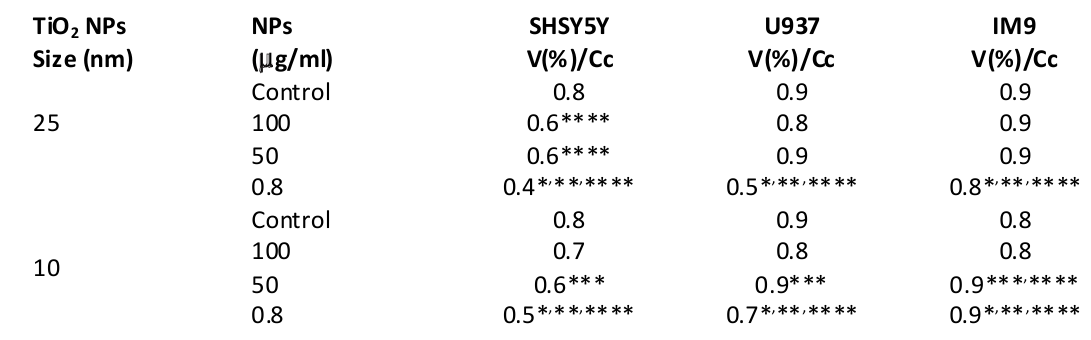
Table 2.: Metabolic activities of SHSY5Y, U937 and IM9 cell lines are indicated by cell viability percentile per cell for three different concentrations of 25 nm and 10 nm TiO bation period.